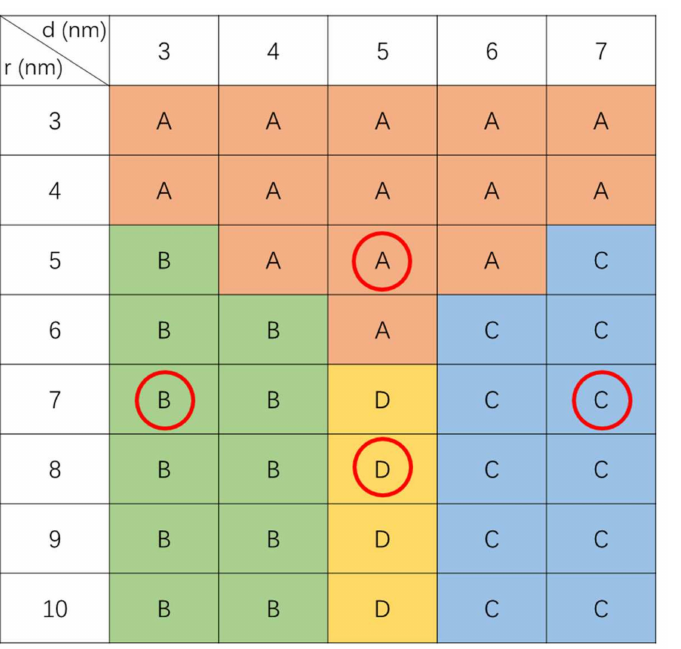
(cid:35) indicates the location of the switching loops shown in Figure 2. The symbols A, B, C, and D represent